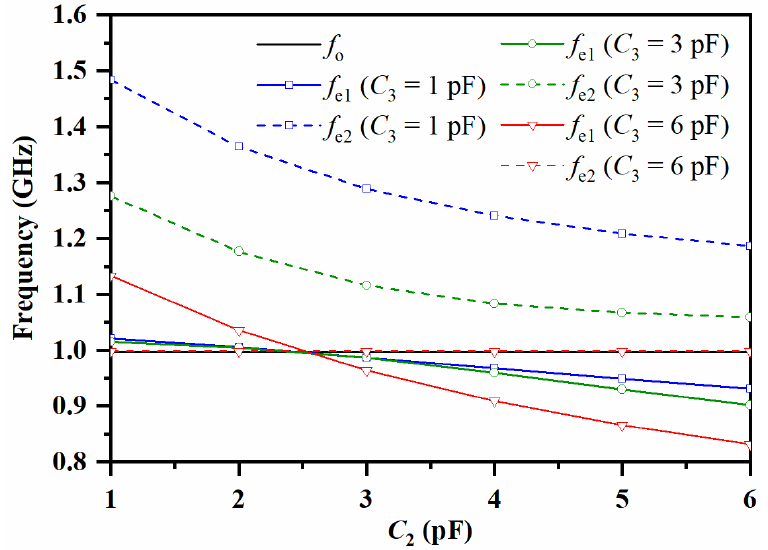
Figure 3. Resonant frequencies f o , f e1 and f e2 versus C 2 with different C 3 ( Y 1 = 1/75 S, Y 2 = Y 3 = 2/75 S, θ 1 = 65°, θ 2 = 60° and θ 3 = 35° at 1 GHz).